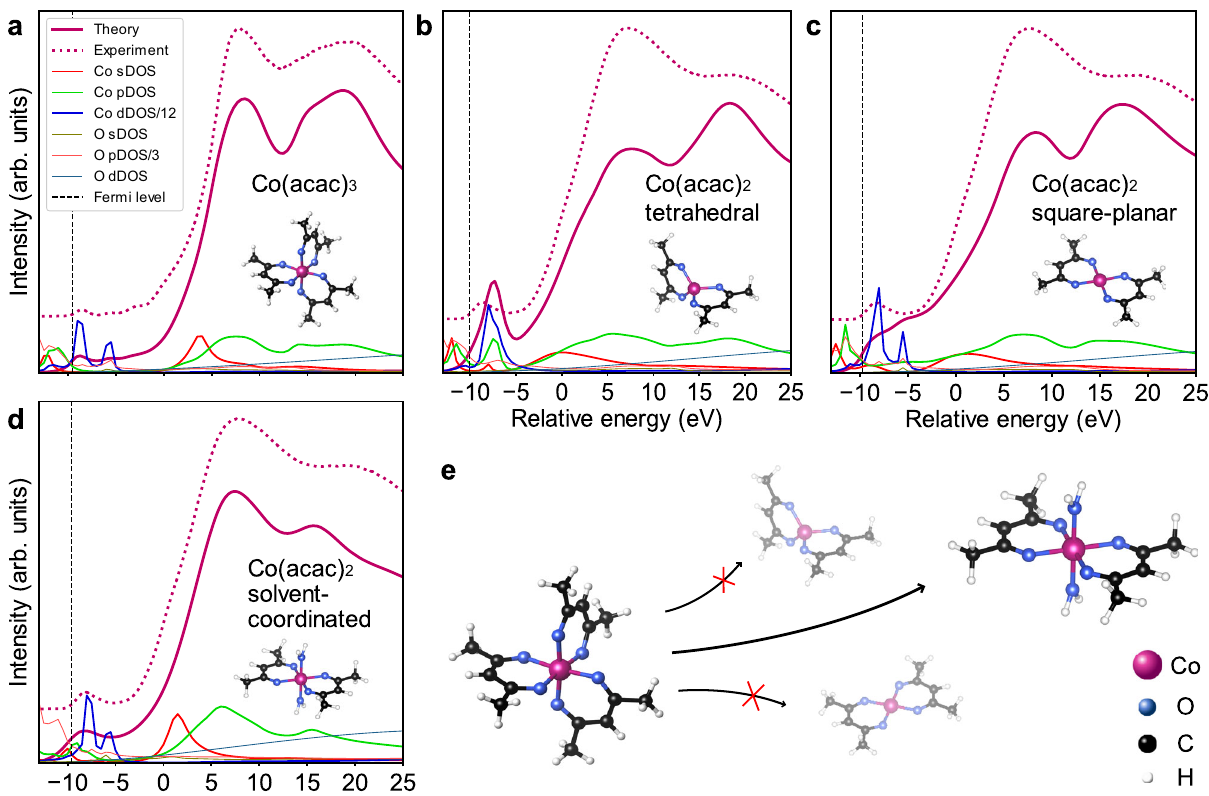
Fig. 3 Structure determination of the reaction intermediate Co(acac) 2 . The structure is determined by means of theoretical XANES spectra calculated using the FEFF code 61 . The spectrum of Co(III) acetylacetonate (acac) is shown in a for comparison. Examined structures include b tetrahedral, c square- planar and d solvent-coordinated with water as a model solvent, since the precise coordination geometry of benzyl alcohol is unknown. The recovered spectra from the MCR-ALS analysis corresponding to Co(acac) 3 and Co(acac) 2 are shown as dotted lines for reference in parts a and b - d , respectively. Spectra are plotted together with the local density of states (DOS) for s, p and d states of cobalt and oxygen atoms. The energy scale is relative to the absorption edge E 0 . The position of the Fermi level is indicated for each structure as a vertical dashed line. No instrumental broadening was necessary for the energy resolution of FEFF calculations to be in good agreement with the experimental HERFD-XANES spectra (for details, see Supplementary Notes 4). e Structural models of the proposed reaction pathway. The atomic positions in square-planar and tetrahedral Co(acac) 2 were taken from reference 62 and the structure of Co(acac) 3 was adopted from reference 63